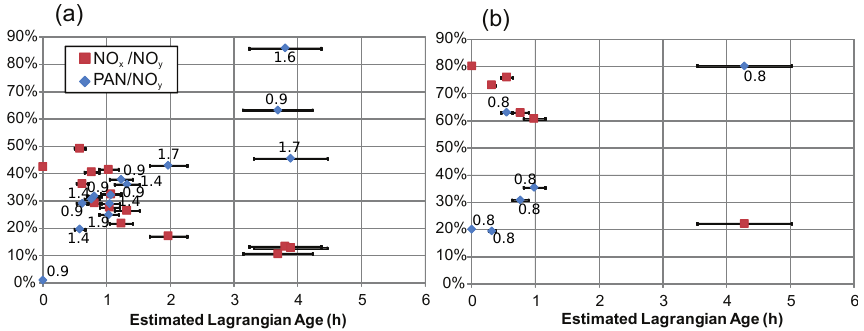
Fig. 4. Fraction of NO y present as NO x (orange squares) and PAN (blue diamonds) versus Lagrangian age for the (a) early pass (13:00– 15:00LT) and (b) late pass (18:20–19:40LT) of the Lake McKay fire plume. The late pass figure only includes samples taken below 1km in altitude; altitude (in km) is given in the text lebels attached to the blue diamonds.